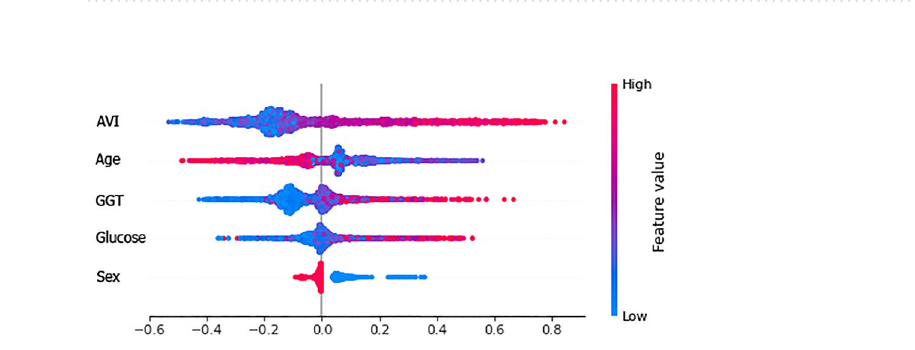
Figure 7. Global interpretation using Shapley values of anthropometric and biochemical parameters considered during training.